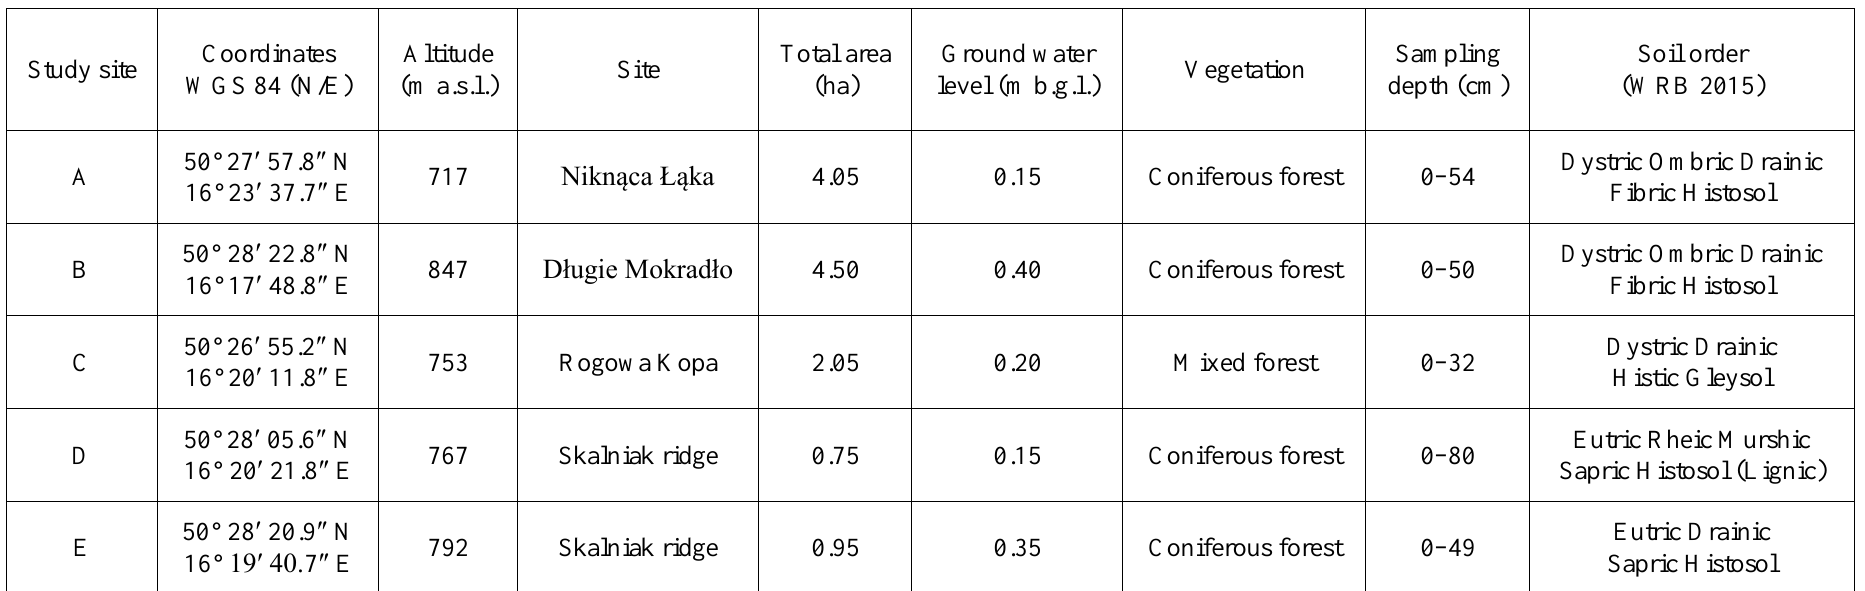
Table 1. Characteristics of the sampling